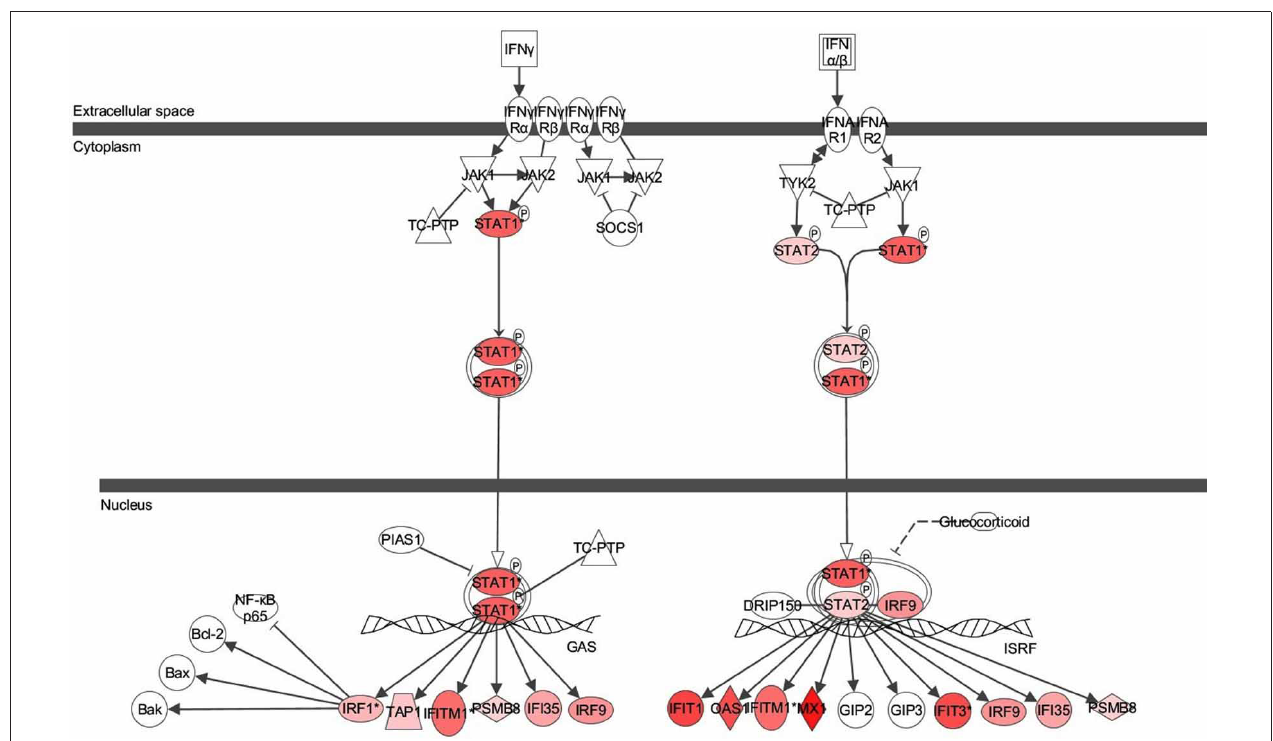
FIGURE 3 | Ingenuity pathway analysis (IPA) of Interferon Signaling Pathway of genes differentially expressed in the bronchial epithelial cells exposed to Alternaria alternata spores. Genes that are significantly up-regulated are shown in red. The intensity of red corresponds to an